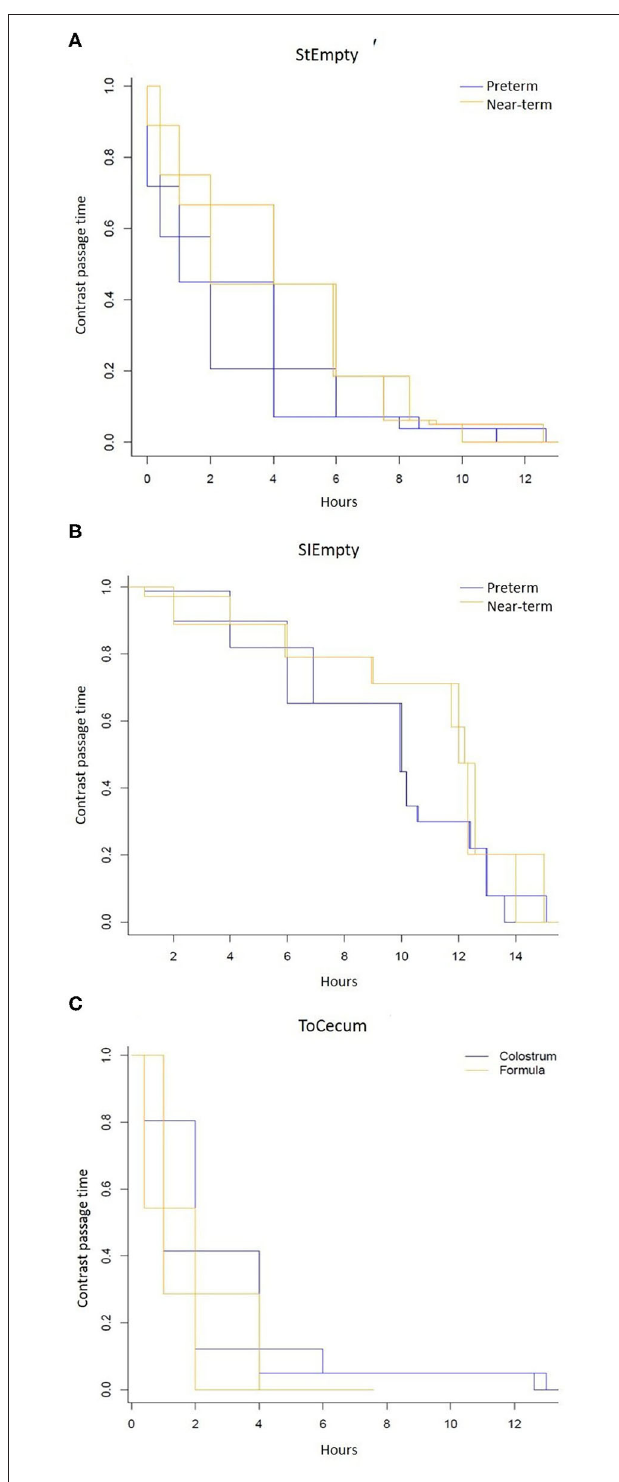
FIGURE 2 | Contrast passage rate measured by serial of x-ray images after intake of contrast solution in 4 d-old immature piglets. (A) Stomach emptying time (StEmpty) in preterm and near-term piglets. (B) Small intestinal emptying time (SIEmpty) in preterm and near-term piglets. (C) Time for the contrast to reach the caecum (ToCaecum) in piglets fed formula or bovine